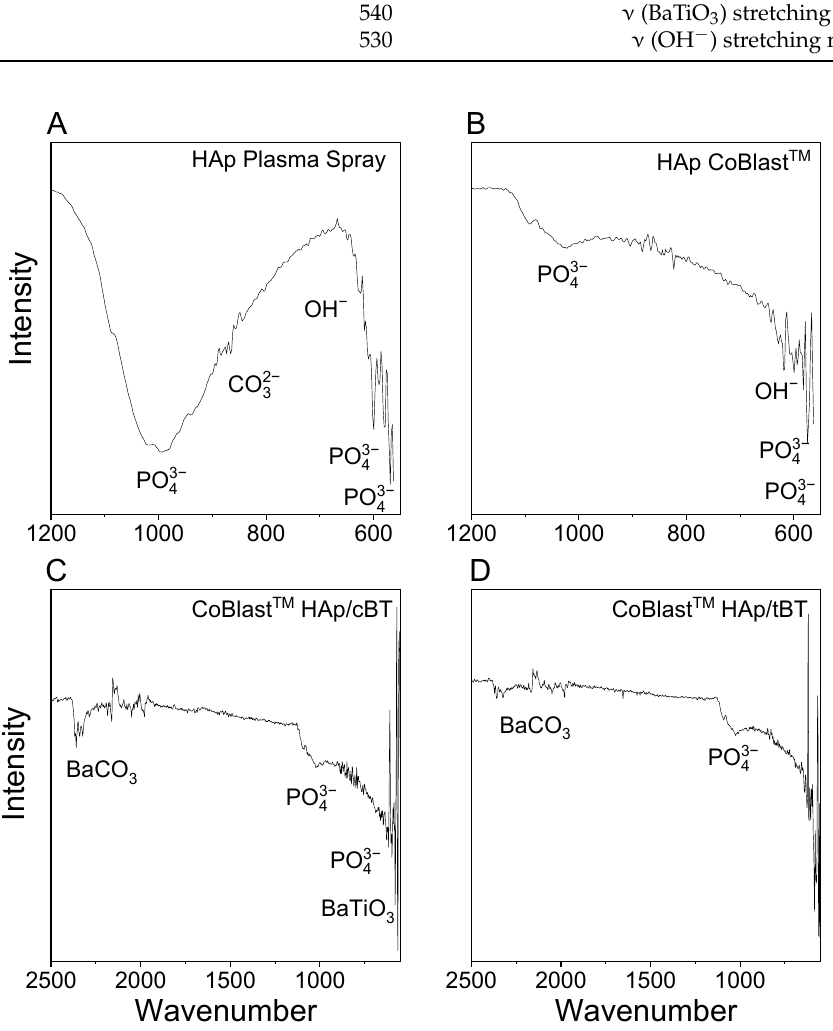
Figure 3. FTIR spectra of HAp by Plasma Spray coating ( A ) and coatings by CoBlast TM with HAp ( B ), 80%/20% of HAp/BaTiO 3 cubic structure ( C ), 80%/20% of HAp/BaTiO 3 tetragonal structure (D). Table 4. Assignment of FTIR spectra of HAp by PS and HAp, HAp/cBT and HAp/tBT by CB coatings presented in Figure 3 [47–52].